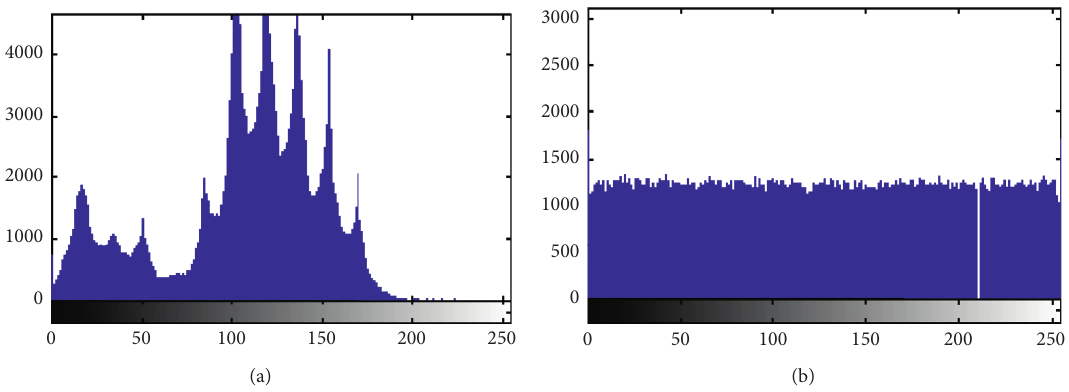
Figure 5: Histograms of the (a) original image and (b) encrypted images.